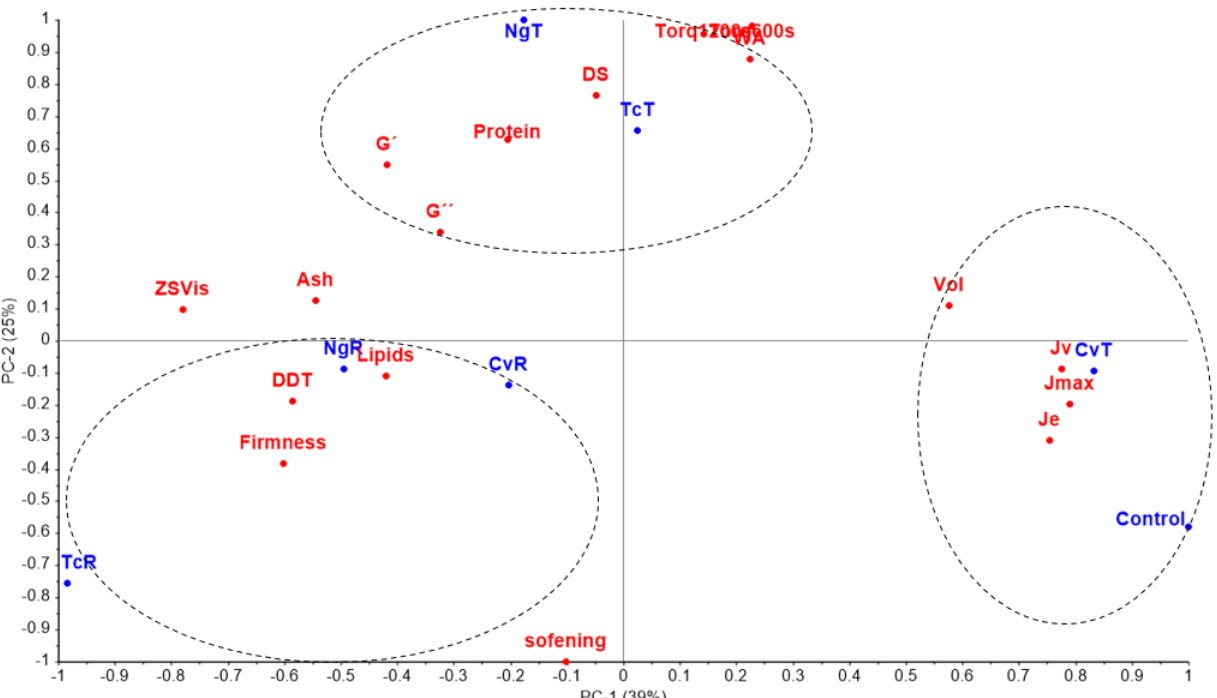
Figure 4. PCA Bi-plot demonstrating relationship among rheology tests: farinograph (WA = water absorption, torque600s, torque1200s, softening is dough softening), oscillatory, (G’ and G”) creep (Jmax, Je, Jv, ZSV is zero shear viscosity), bread (firmness, vol is volume), and nutritional properties for the doughs and breads made with control and Tetraselmis chuii (TcR), Tetraselmis chuii ethanol- treated (TcT), Chlorella vulgaris (CvR), Chlorella vulgaris ethanol-treated (CvT), Nannochloropsis gaditana (NgR) and Nannochloropsis gaditana ethanol-treated (NgT). Blue colour for the samples and red colour refers to measurements parameters.